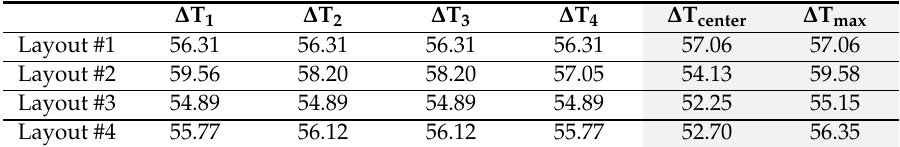
Figure 13. Representation of four layouts corresponding to a four-source die. The temperature-sensing points are located at the center of the die and at the centers of the HSs. Table 1. Temperature rises over ambient (K) computed by TRIC.